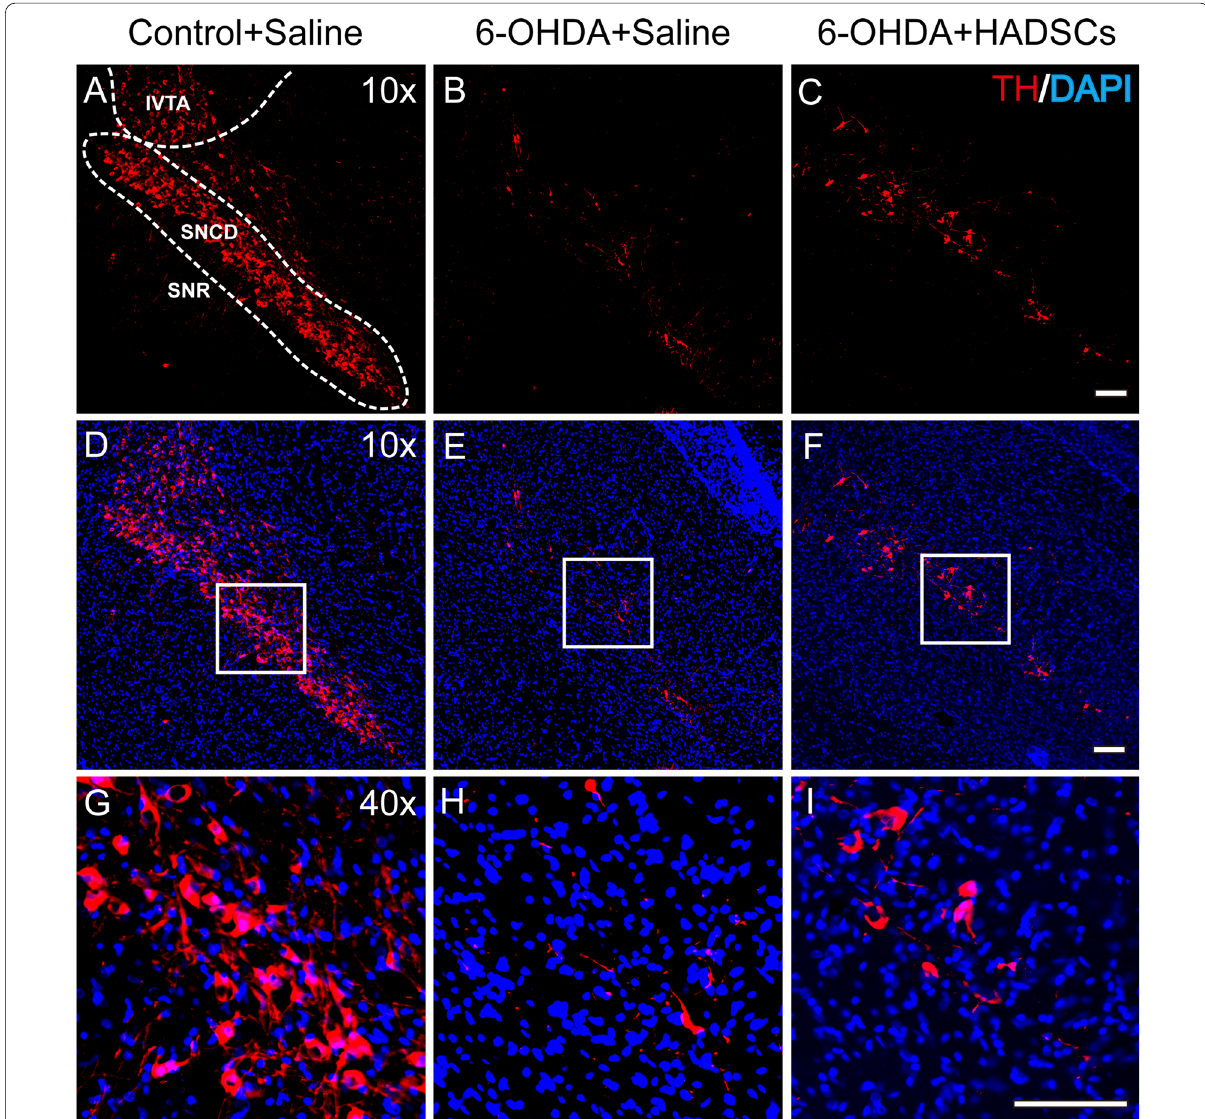
Fig. 8 Immunostaining against TH in the substantia nigra of the rats receiving saline ( a , d , g ), PD rats receiving saline ( b , e , h ) or PD rats receiving USPIO-PAA/PEG NPs-labeled HADSCs ( c , f , i ). The area in the dashed frame indicates the compact area of substantia nigra (SNc) and the ventral tegmental area (VTA). Images in the boxes of d , e , f are enlarged and shown in g , h , i , respectively. There are less TH-expressing cells in the SNc and VTA regions in the rats receiving 6-OHDA injection, as compared to the controls receiving saline. Following by HADSC transplantation, more of TH-expressing cells in the SNc of PD rats could be observed. The bar represents 100